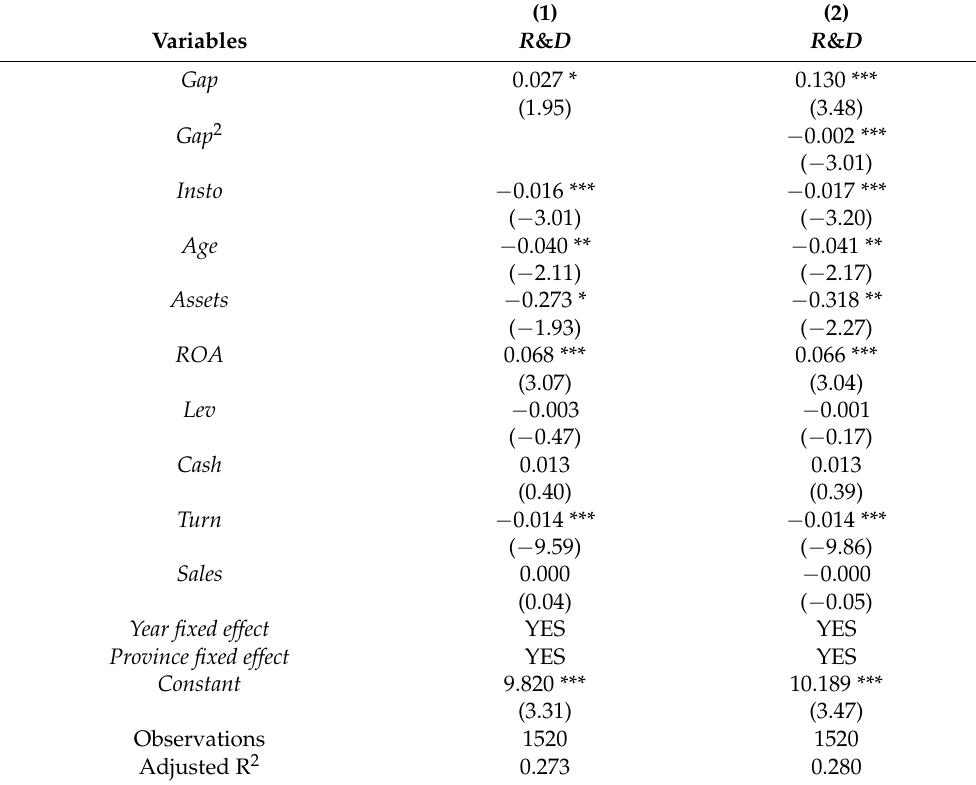
Table 3. Impact of internal compensation gap on innovation